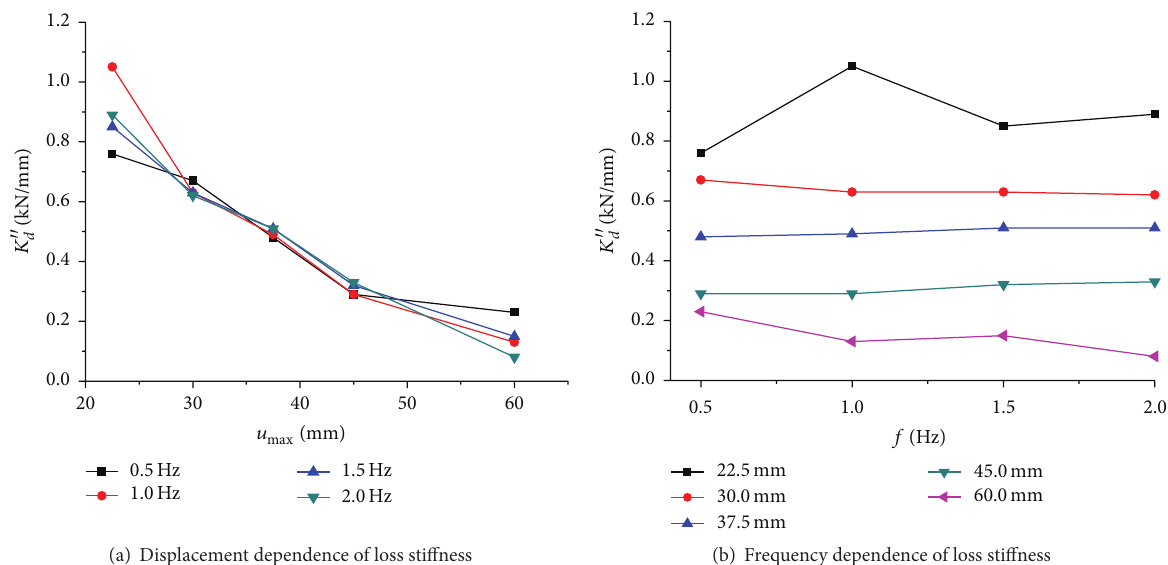
Figure 7: The characteristics of the loss